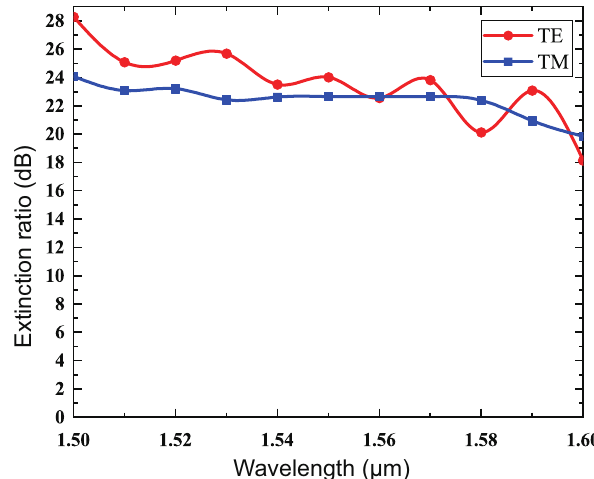
Figure 7. The simulated extinction ratio of the MZI for both TE and TM